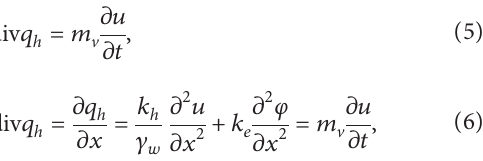
Figure 11: Fitted curves of the electro-osmotic permeability co- efficient over treatment